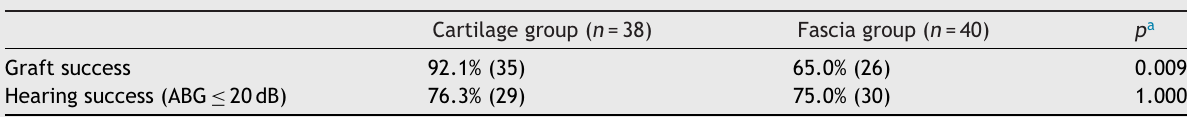
Comparison of success rates between the groups.